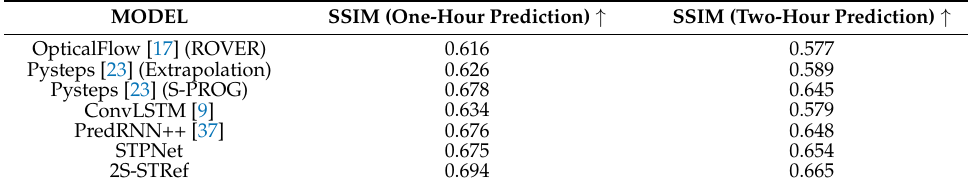
Figure 9. Loss function curve during the training period. The model can effectively converge. Table 5. Image quality comparisons of radar echo prediction.